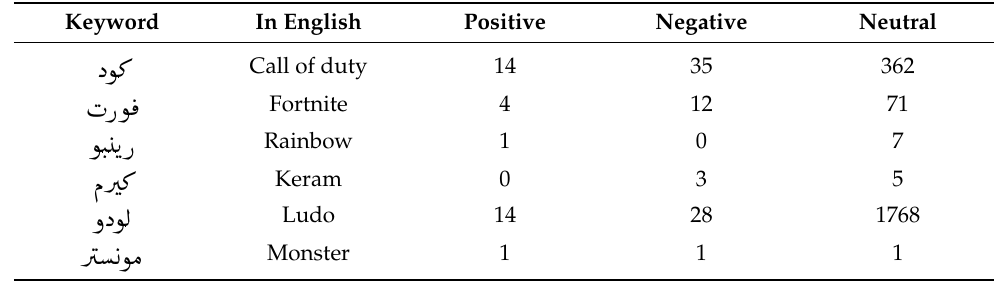
Table 6. Games’ keywords sentiment